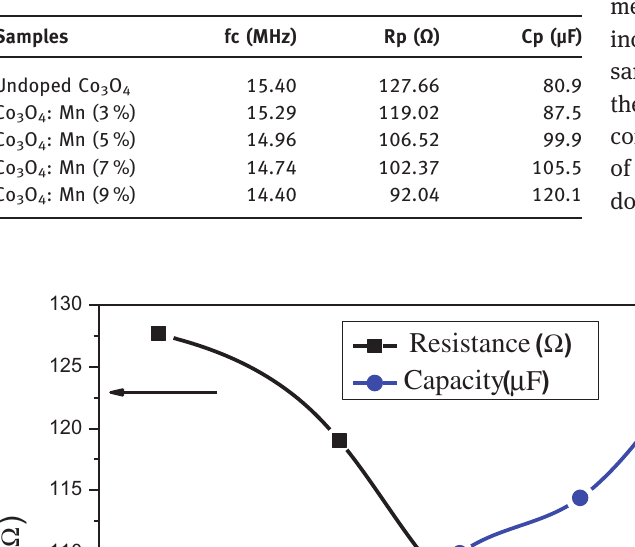
Table 3: Values of fc, Rp and Cp of Mn-doped Co 3 O 4 films.